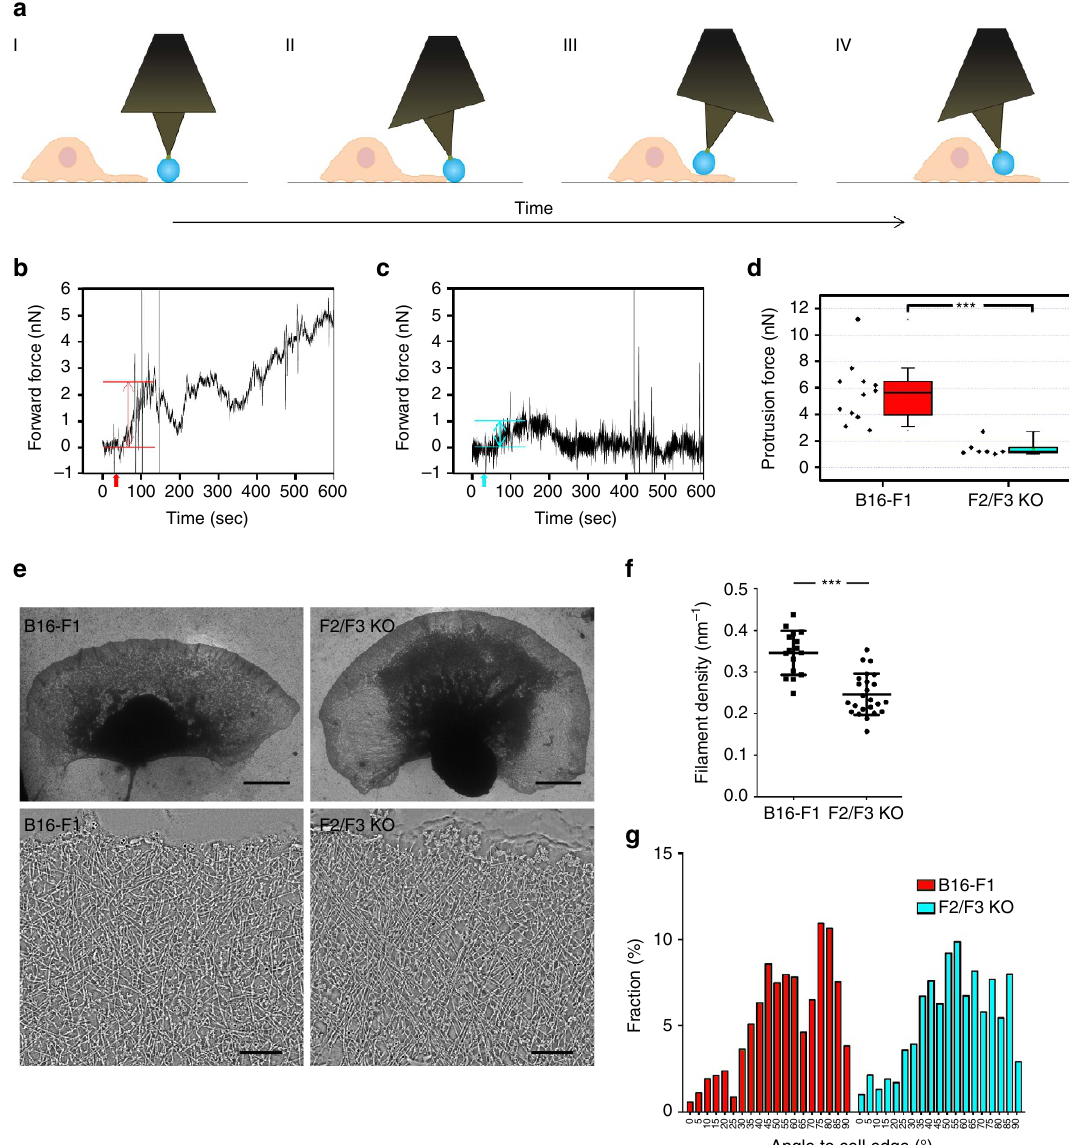
Figure 6 | Loss of FMNL2/3 affects ultrastructure and force generation of lamellipodia. ( a ) Schematic illustration of experimental stages. A modified cantilever is placed at a preset force of 1nN in front of and perpendicular to a migrating cell (I). The cell pushing against the bead causes a lateral deformation of the cantilever (II). If the cell is strong enough to migrate further, the cantilever is lifted and laterally deflected into the opposite direction due to retrograde flow of lamellipodium and lamella (III). Finally, the cell body causes a much higher deflection of the cantilever (IV). ( b ) Measurement of a B16 wild-type cell representative for the force deflection curve typically derived from the series of events depicted in a . The red arrow on the time axis indicates first contact between cell and bead. The red double-arrow shows the amount of protrusion force exerted by the lamellipodium. The rest of the curve is explained by stages depicted in a (experimental stages III and IV). ( c ) Representative measurement of FMNL2/3 double-knockout cell. Turquoise arrow on time axis and double-arrow indicate first cell/bead contact and protrusion force exerted by the KO-cell, respectively. Commonly, KO cells were not strong enough to lift the bead onto the lamellipodium, but instead frequently changed direction of migration. ( d ) Summary of protrusion force experiments shown as box and whiskers plots. ( e ) Overview images of transmission electron micrographs of representative wild-type (B16-F1) or FMNL2/3 double-KO cells, as indicated (top) and 5.5 m m electron tomography slides showing respective actin filament network at the leading edge (bottom). Scale bars, 10 m m (top panels), 100nm (bottom panels). ( f ) Quantification of projected filament density from four different regions per analysed cell. Data are displayed as arithmetic means ± s.d. ( g ) Histogram of angles subtended by filaments to the leading edge (90 (cid:2) corresponding to filaments perpendicular to the leading edge). *** p o 0.001 by Mann–Whitney rank sum